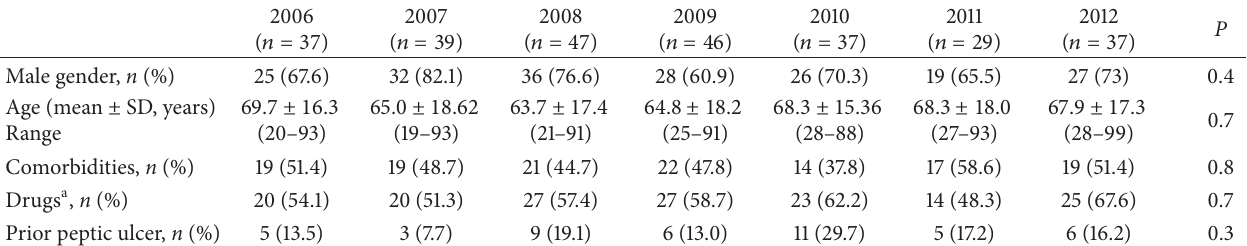
Table 1: Demographic and clinical characteristics of patients with peptic ulcer bleeding.